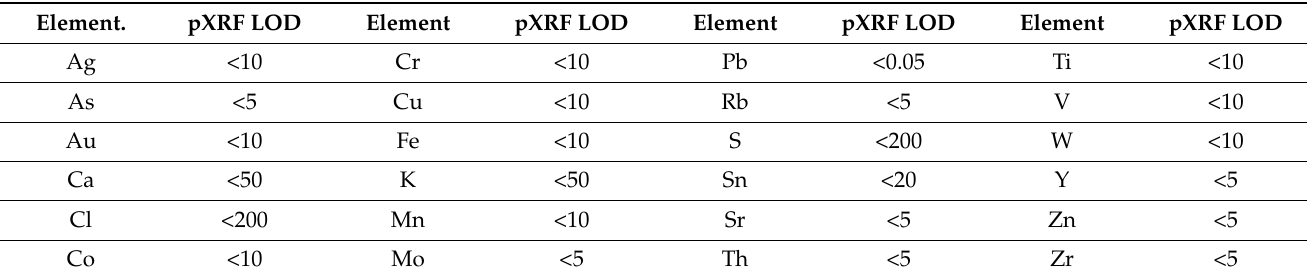
Table 2. Limits of detection (LOD) for some important elements (in µ g/g) across the periodic table by portable XRF